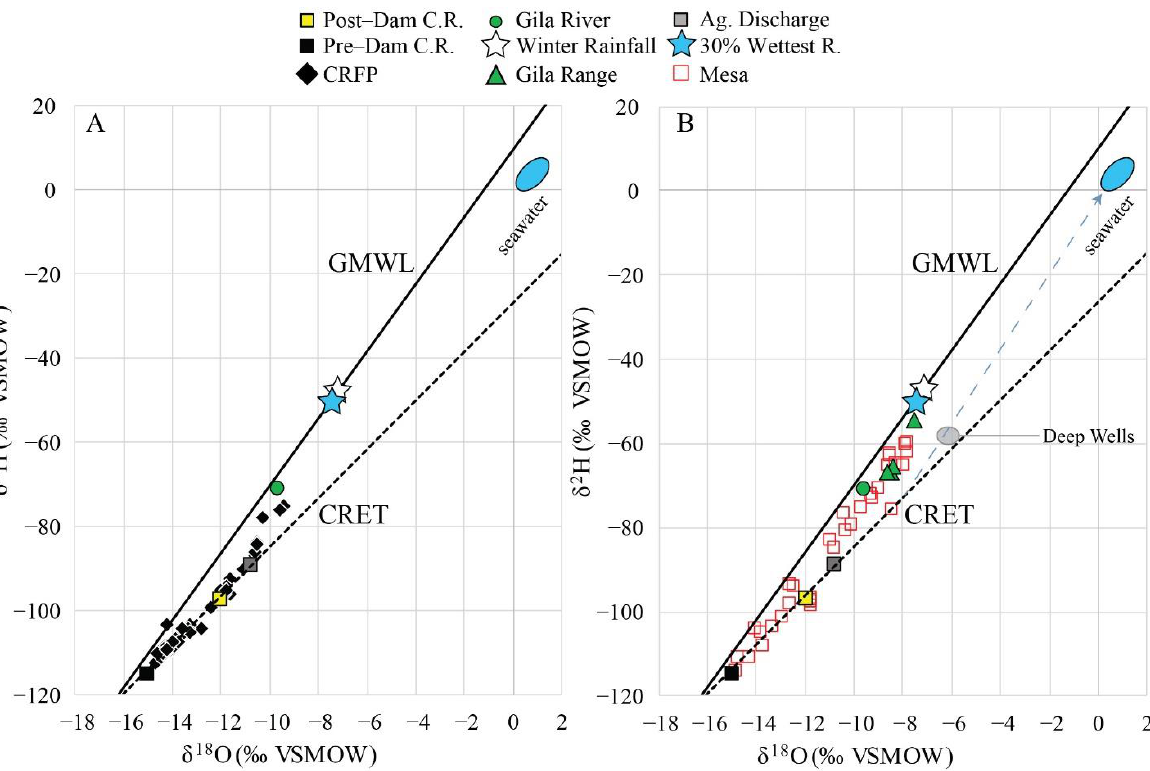
Figure 8. ( A ) δ 18 O and δ 2 H values of surface water and groundwater from the Colorado River floodplain (CRFP). ( B ) δ 18 O and δ 2 H values of waters from the San Luis and Yuma Mesas, Gila Range relative to the GMWL and the CRET. Deep well data from [41]. Dashed gray line shows hypothetical mixing between seawater in the Gulf of California [42] and evaporated Colorado River water.